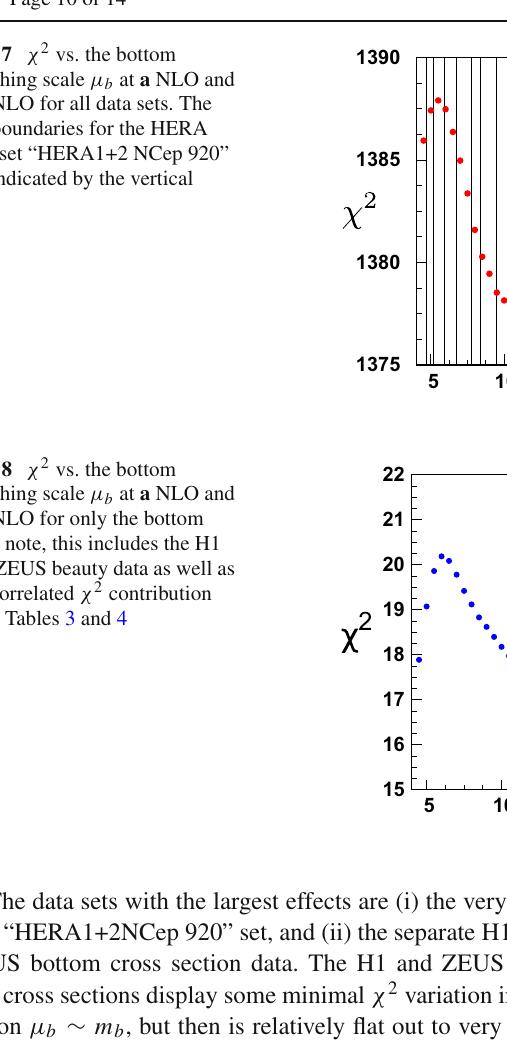
Fig. 7 χ 2 vs. the bottom matching scale μ b at a NLO and b NNLO for all data sets. The bin boundaries for the HERA data set “HERA1+2 NCep 920” are indicated by the vertical lines